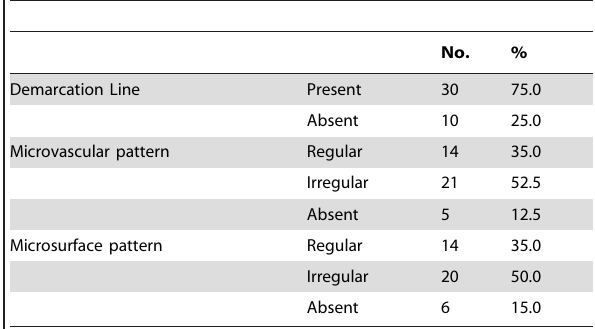
Table 2. M-NBI findings of 40 Gastric Lesions Used in Both